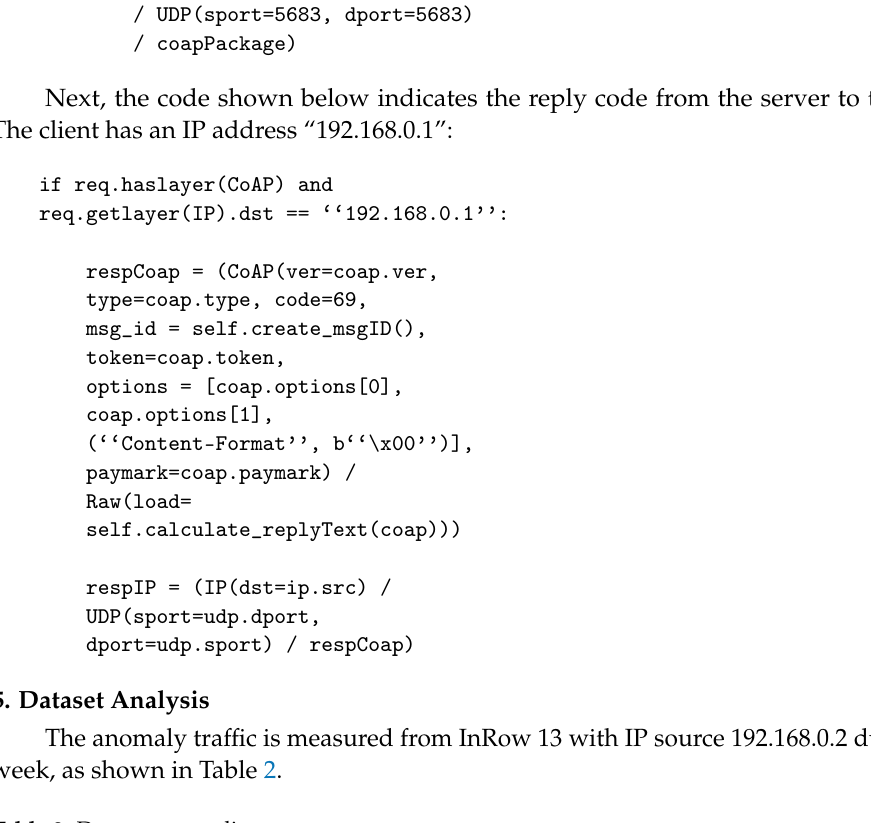
Table 2. Dataset